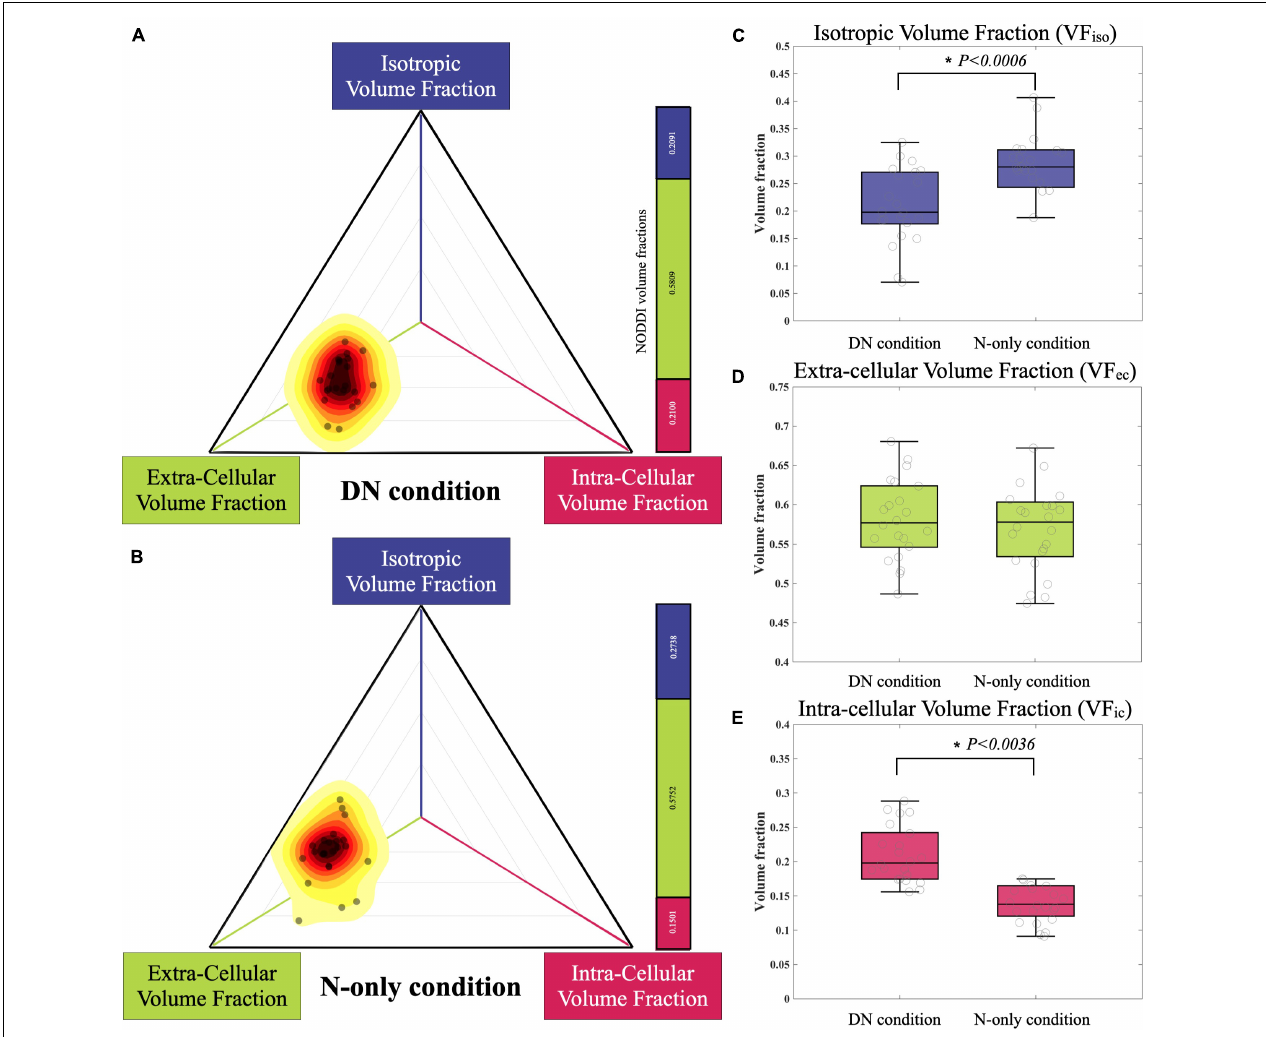
FIGURE 9 | The distribution of NODDI-derived volume fraction in the DN condition and N-only condition are plotted with a 2-D barycentric coordinate system. (A) The N-only condition and (B) distribution reveal a left upper shift in the coordinate system, compared to the DN condition. There is no significant difference in the VF ec ( p = 0.4751, D ). However, there are significant differences in the VF ic ( p < 0.0036, E ) and VF iso ( p = 0.0006, C ). NODDI, neurite orientation dispersion and density